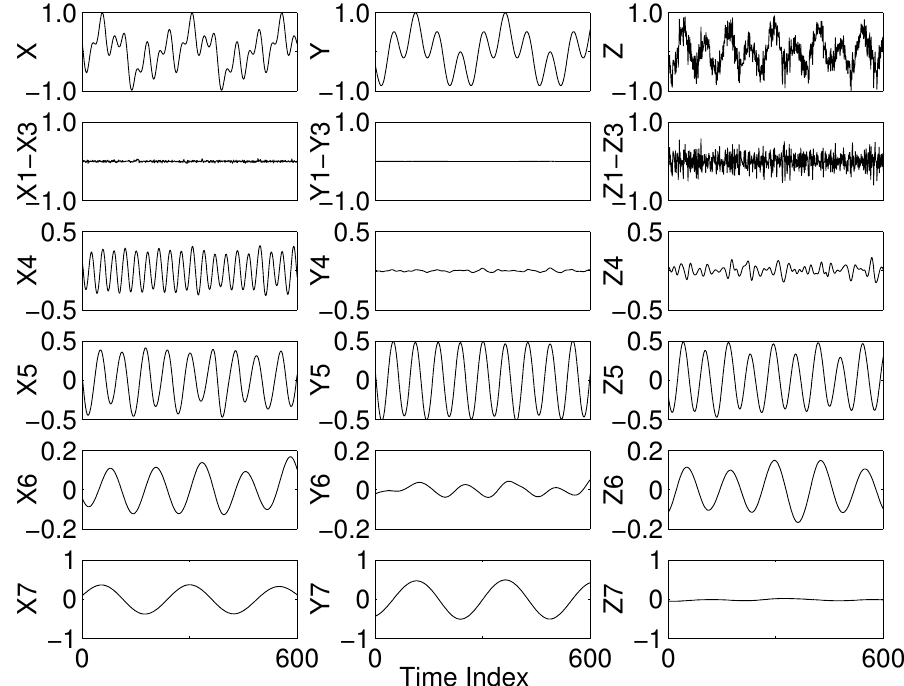
Figure 2. Multivariate EMD (MEMD) decomposition of the same synthetic trivariate dataset as in Figure 1, showing mode alignment and significantly reduced mode